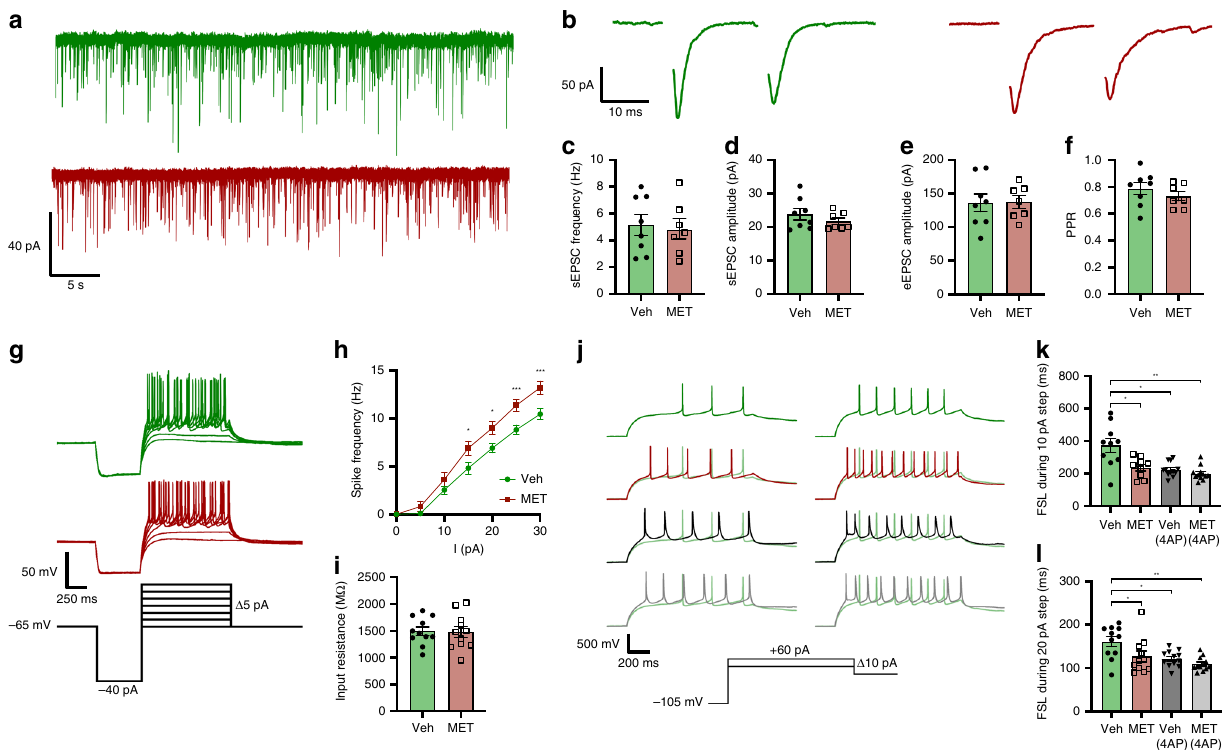
Fig. 6 CORT feedback increases fi rst spike latency and decreases spike output. a Traces of sEPSC from individual CRH neurons from vehicle (green) or metyrapone- (red) treated mice. b Traces of paired-pulse eEPSC amplitudes from CRH neurons from vehicle (green) or metyrapone- (red) treated mice. c Mean sEPSC frequency; unpaired t test, p = 0.8. d Mean sEPSC amplitudes; unpaired t test, p = 0.3. e Mean eEPSC P1 amplitudes; unpaired t test, p = 0.9. f Paired pulse ratio (PPR); Mann – Whitney test, p = 0.3. g Traces of CRH neuron spike output from vehicle (green) or metyrapone- (red) treated mice in response to varying current steps. h Spike frequency plotted for each 5pA step; n = 11 per group, RM two-way ANOVA, * p < 0.05 vs. vehicle, Holm – Sidak; ANOVA interaction p = 0.09, ANOVA main effect of group p < 0.001. i Input resistance from individual CRH neurons; unpaired t test, p = 0.9. j CRH neuron responses to 10pA (left) and 20pA (right) current steps with or without prior incubation with 4AP (Veh + 4AP in black, MET + 4AP in gray). k , l FSL during 10pA ( k ) and 20pA ( l ) steps from vehicle and metyrapone-treated mice with or without 4AP incubation. RM two-way ANOVA * p < 0.05 Holm – Sidak; ANOVA interaction p = 0.003, ANOVA main effect of group p <0.001. All data are presented as mean ± SEM, * p < 0.05, ** p < 0.01, *** p <